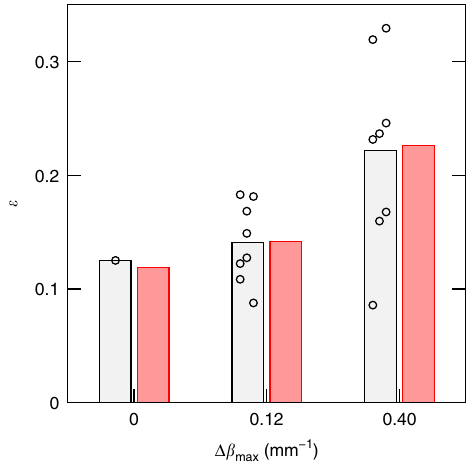
Figure 5 | Averaging over different noise realizations. Experimentally measured transfer efficiency in photonic maze structures with the topology of Fig. 3 and propagation length t ¼ 60mm. Both uniform and different noise maps with D b max ¼ 0.12mm (cid:2) 1 and D b max ¼ 0.40mm (cid:2) 1 have been implemented. The light grey (left) bars indicate the average over several experimental results obtained for different noise maps with the same amplitude D b max (single measurements are reported as open circles). The red (right) bars represent the expected average transfer efficiency, numerically simulated for 1,000 different noise maps with the given D b max . Error bars are smaller than the mark